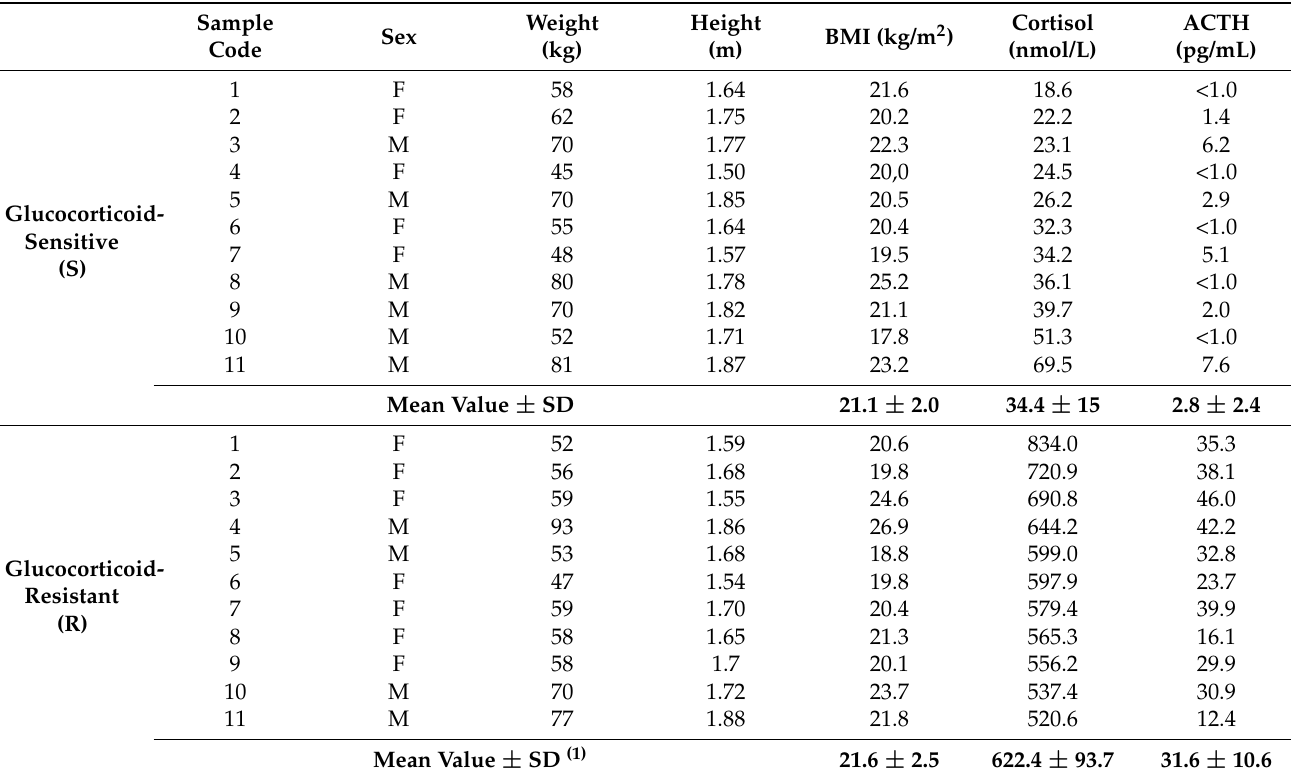
Table 1. Clinical characteristics, serum cortisol and plasma ACTH concentrations of the most glucocorticoid-sensitive (S) and most glucocorticoid-resistant (R) healthy subjects at the time of the very-low dexamethasone suppression test. Sample Weight Sex Code